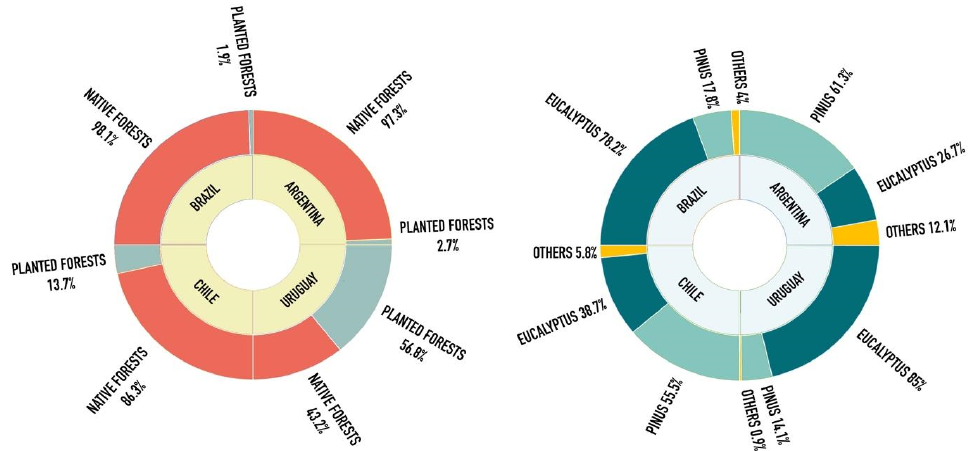
Figure 1. Percentage of native and planted forests (left) and percentage of commercial species (right) for Argentina, Brazil, Chile, and Uruguay.